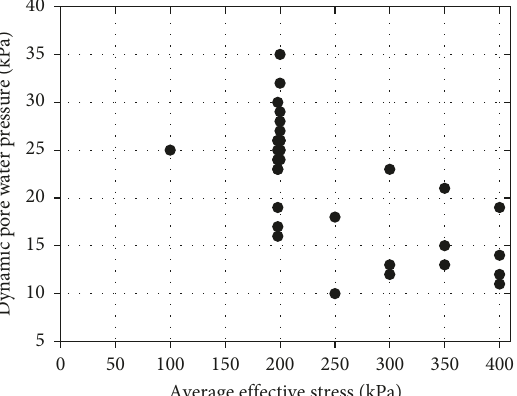
Figure 5: Relationship curve of the maximum dynamic pore water pressure and the maximum deviatoric stress.